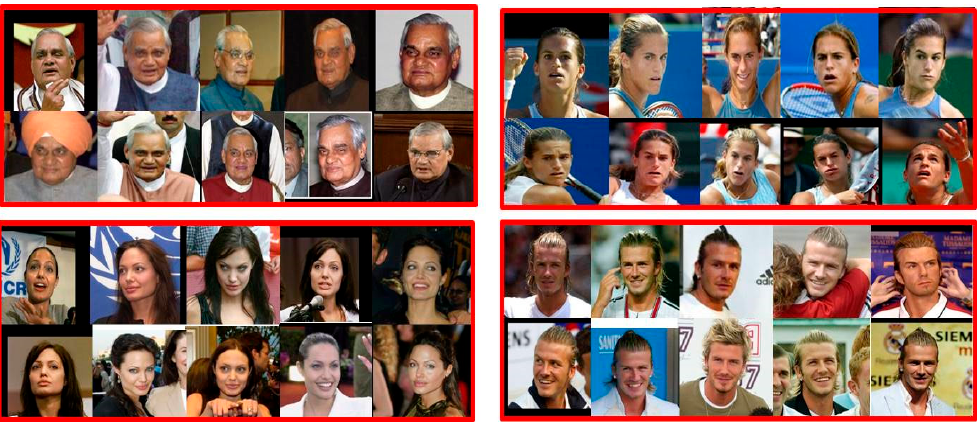
Figure 9. Sample of experiment 1 clusters.